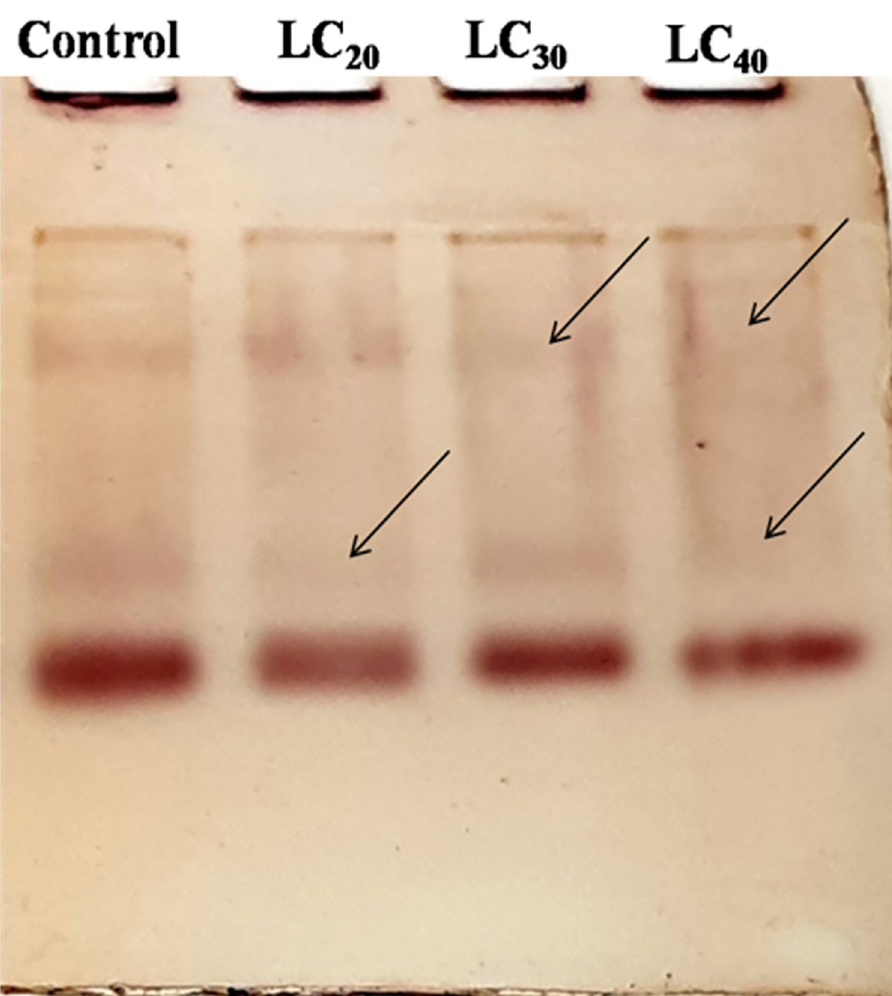
Fig 3. Qualitative analysis of acid phosphatises of T . castaneum adult after treatment with essential oil of C . Citrons